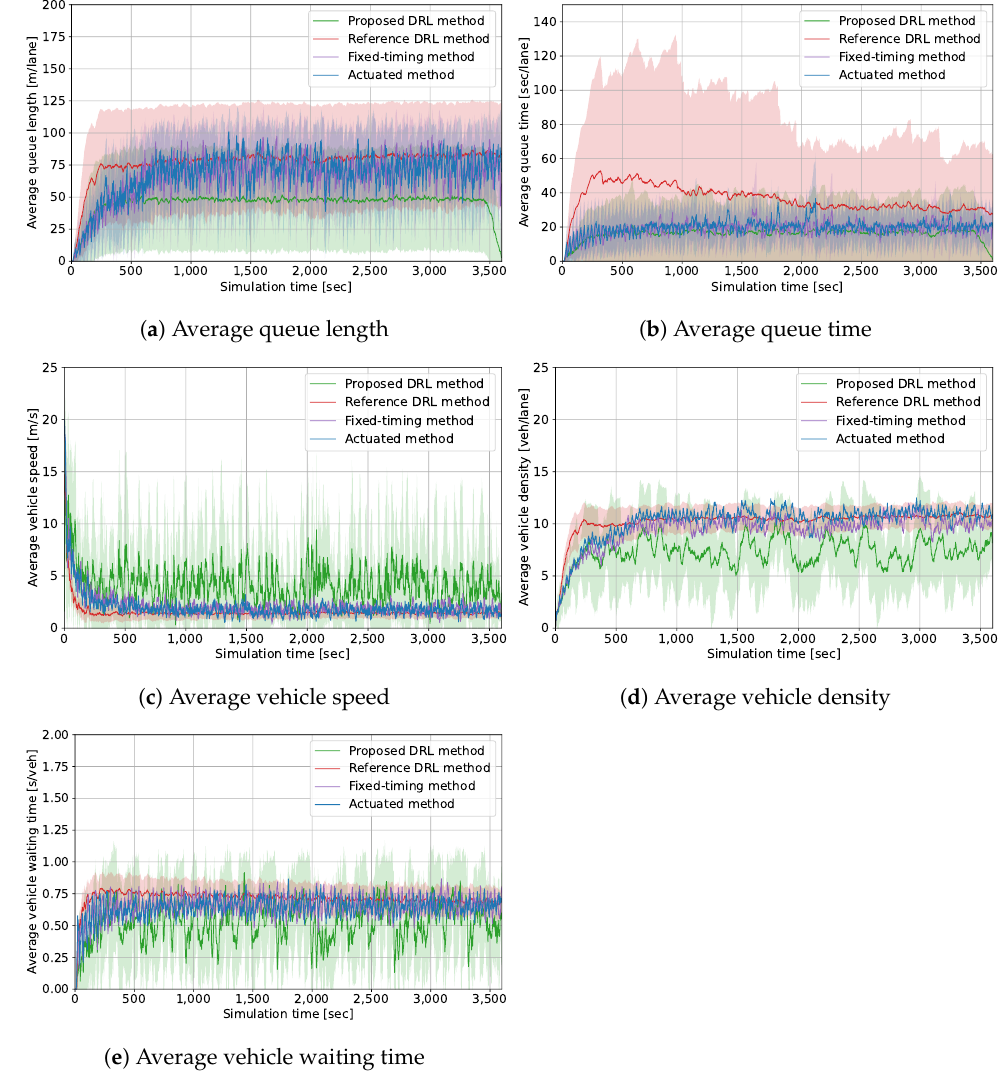
Figure 11. Simulation comparisons with